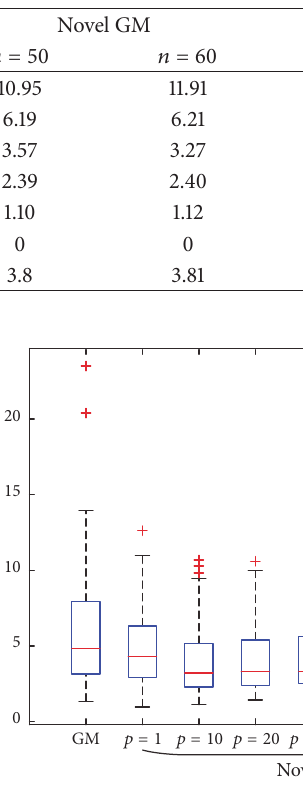
Figure 9: Box plot of RMSEs at different values of 𝑛 in the novel GM and GM.